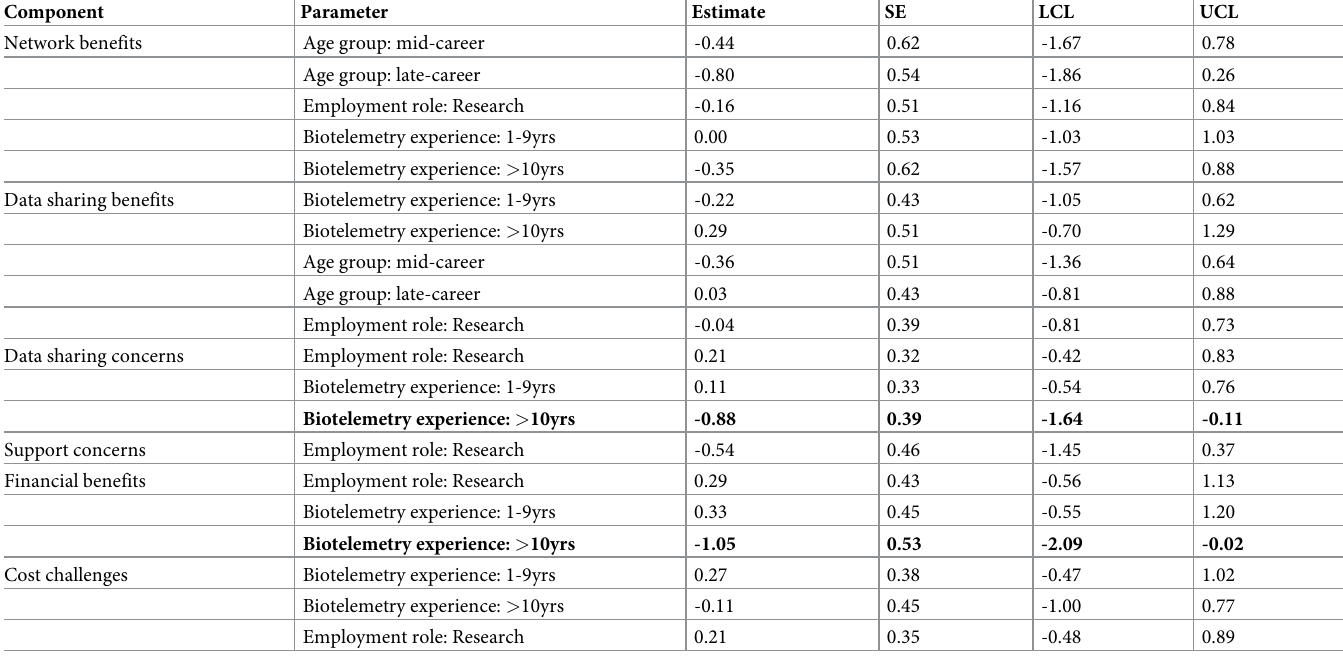
Table 2. Model averaged estimates for competing models ( Δ AICc < = 2; S1 Table) for each PCA component, where component score was the dependent variable and independent variables included age group (reference level = early career), employment role (reference level = non-research) and/or years of biotelemetry experi- ence (reference level = no experience).